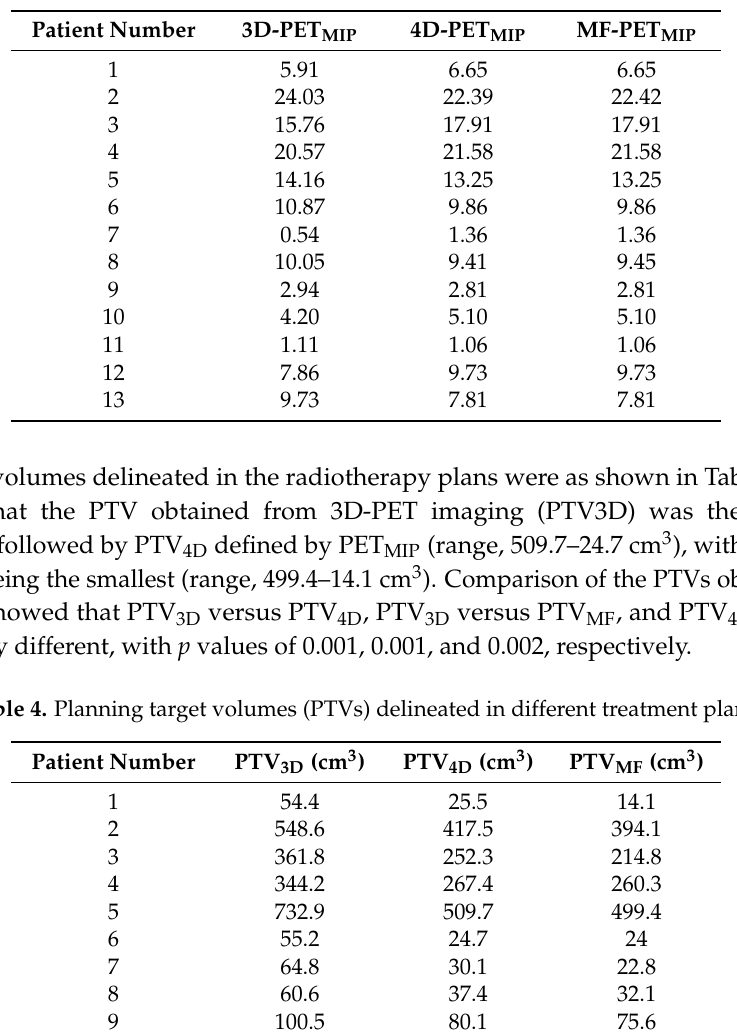
Table 3. Standardized uptake value (SUV) max value in different PET MIP images. MIP-maximum intensity projection.